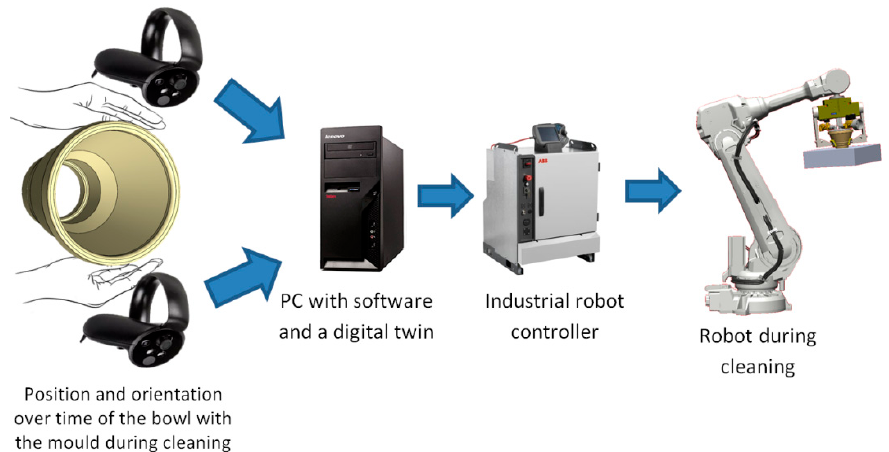
Figure 7. Flow of information regarding the position and orientation of the bowl with the mould.